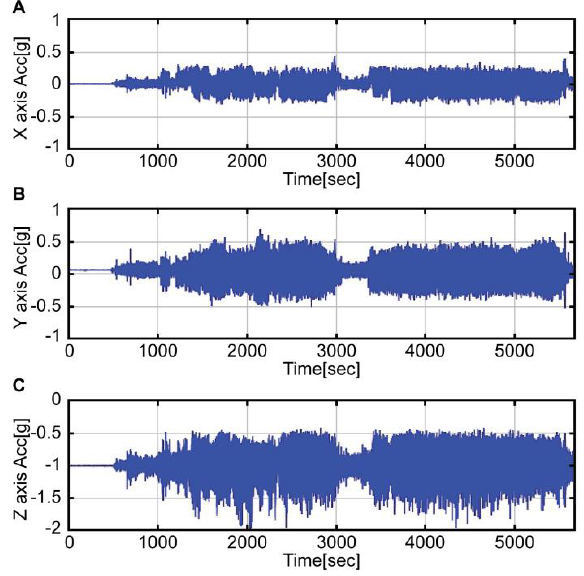
Figure 4. X, Y, Z acceleration by the MEMS accelerometer.